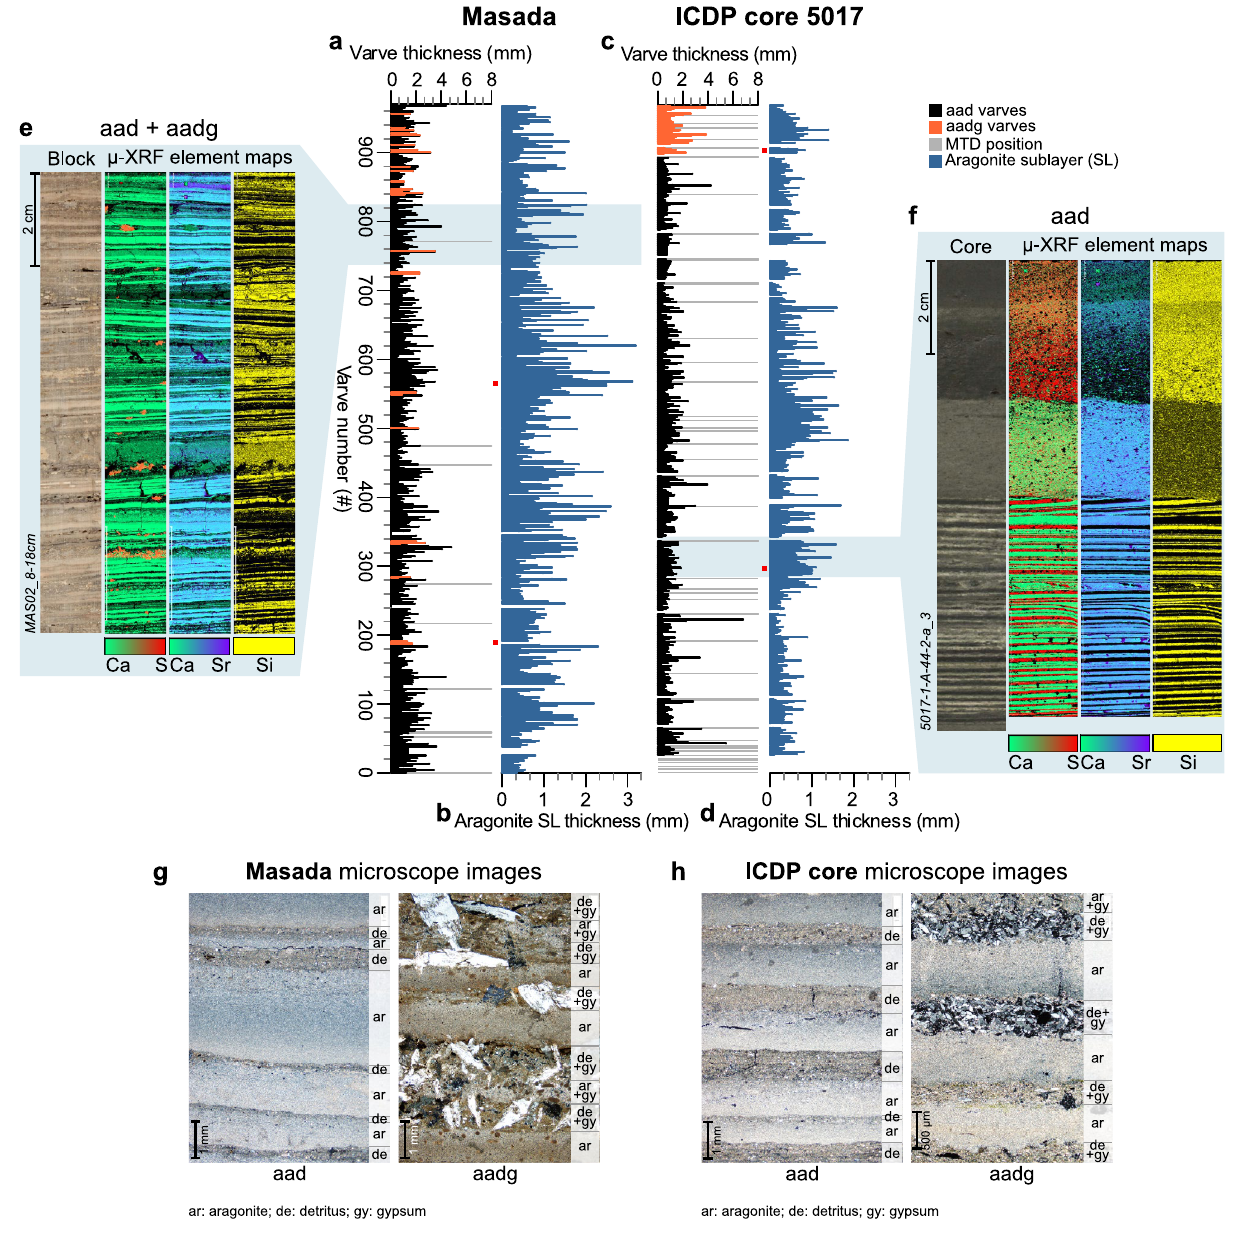
Figure 4. Aragonite varves of the ULi-aad. Varve ( a ) and aragonite sublayer (SL) thicknesses ( b ) for Masada and varve ( c ) and aragonite sublayer (SL) thicknesses ( d ) for the ICDP core. In the varve thickness plots ( a , c ) aadg varves are marked in orange and MTDs as grey bars. Gaps in the ICDP core ( c , d ) are due to erosion of varves by MTDs and were estimated from parallel Masada varve counts. Gaps in the Masada profile ( a , b ) are due to folded varves that were counted without thickness measurements. Note: two phases of increased aragonite sublayer thickness at both sites ( b , d ). Red points in ( a , c ) mark position of thin section images ( g , h ). Blue shading indicates position of 2D µ-XRF element maps ( e , f ) of resin-impregnated sediment blocks: ( e ) Prolonged period of 89 continuous varve formation at Masada and ( f ) 54 years of calm and undisturbed aragonite varve formation followed by MTDs in the ICDP core. Aragonite sublayers (blue colors in Ca + Sr maps) alternate with detrital sublayers (yellow Si maps) in aad varves. Orange colors in Ca + S maps indicate gypsum. ( g , h ) Microscope images of aad and aadg varves from Masada ( g ) and the ICDP core ( h ). Note the different